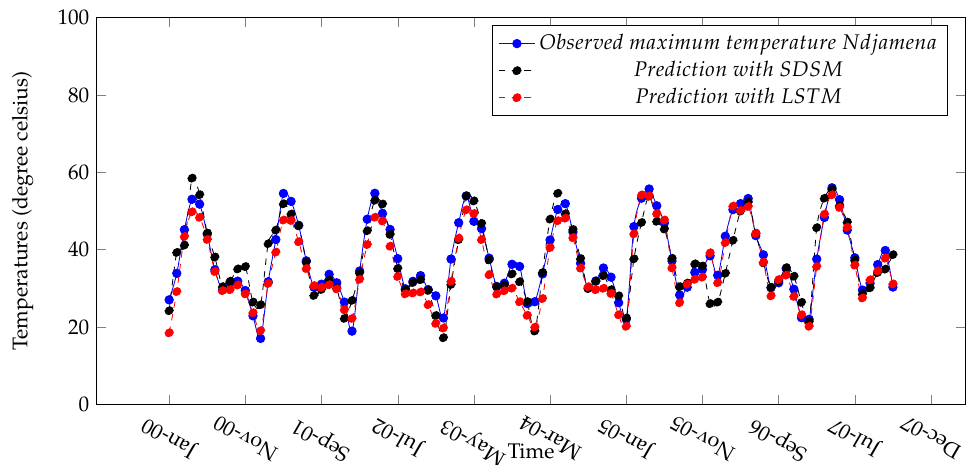
Figure 14. Observed and predicted maximum temperature in